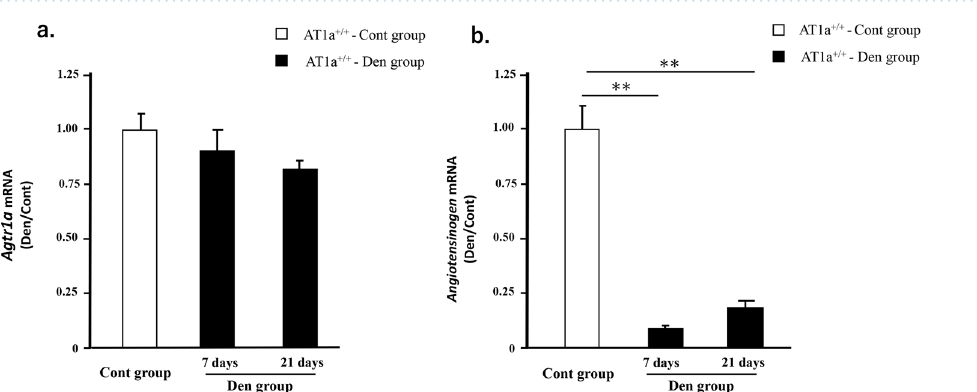
Figure 6. Denervation did not upregulate the gene expressions of AT1a receptor ( Agtr1a ) and angiotensinogen in gastrocnemius muscle of AT1a +/+ mice. ( a , b ) Gene expressions of Agtr1a ( a ) and angiotensinogen ( b ) in gastrocnemius muscle were evaluated by RT-qPCR in AT1a +/+ mice. Expression levels of these transcripts in each sample were normalized to 18S rRNA expression levels and were shown as the fold increase or decrease in mRNA expression in the Den group compared with the Cont group in mice. AT1a +/+ -Cont group, n = 6; AT1a +/+ -Den group at 7 days postdenervation, n = 7; AT1a +/+ -Den group at 21 days postdenervation, n = 7. Values are means ± SE. **P <